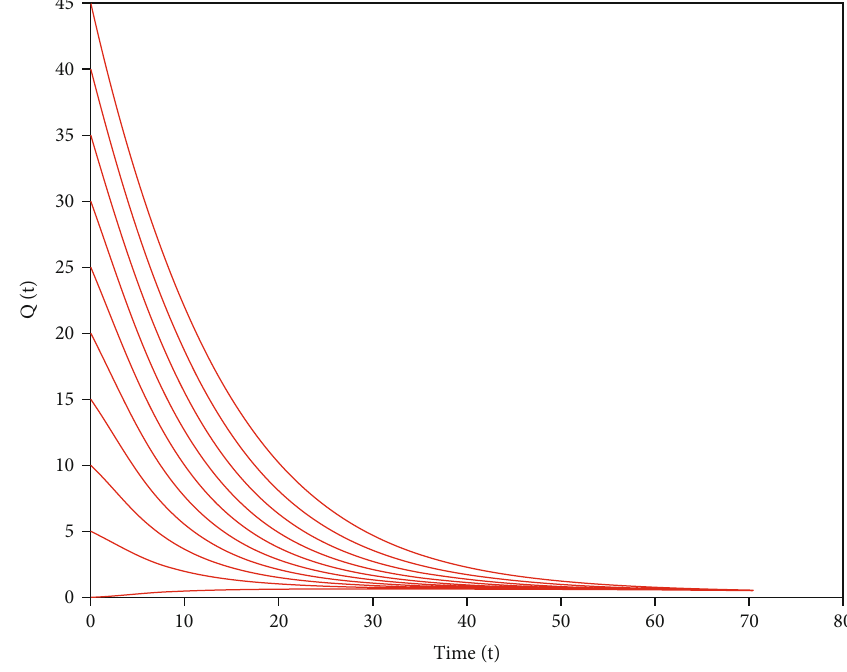
Figure 6: The stability curves of Q ð t Þ at E ∗ for ω = 0 : 97 and ν = 0 : 5